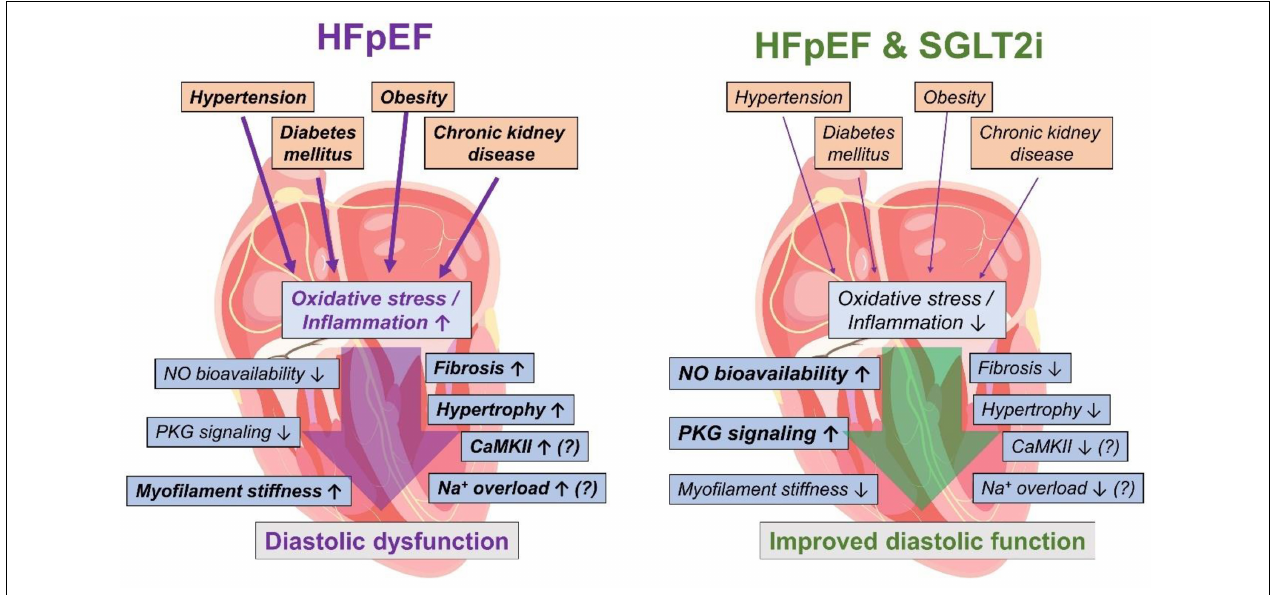
FIGURE 3 | Pathophysiology involved in HFpEF leading to diastolic dysfunction (left) and possible beneficial mechanisms of SGLT2i in HFpEF (right). HFpEF, heart failure with preserved ejection fraction; NO, nitric oxide; PKG, protein kinase G; CaMKII, Ca 2 + /calmodulin-dependent protein kinase II δ ; SGLT2i, sodium-glucose-cotransporter 2 inhibitors. The heart image is licensed by Shutterstock.com/Usama Nasir